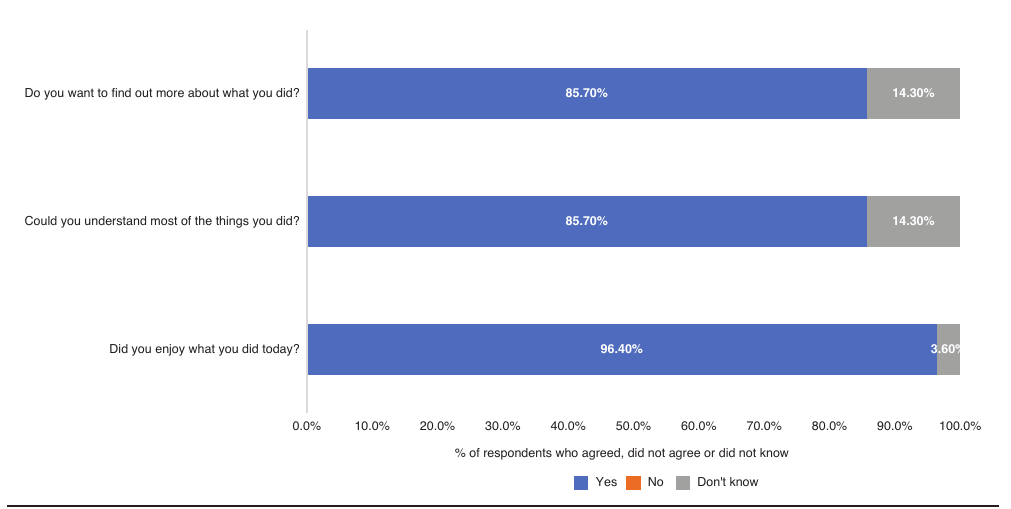
Figure 5: Pupils’ understanding and enjoyment after Session 1 (percentages from 348 responses) (source: